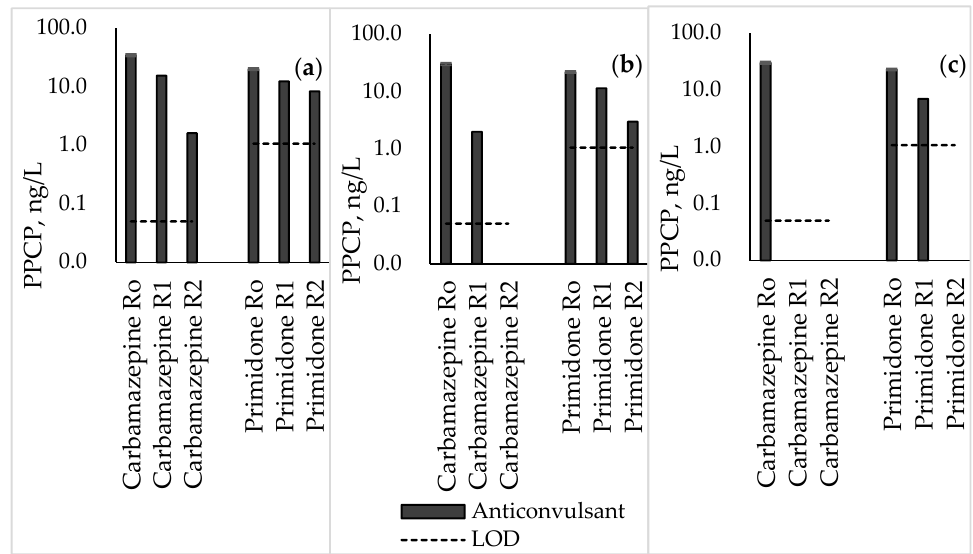
Figure 5. Concentrations of two anticonvulsants in the feed secondary effluent (R o ) and effluent of the R 1 and R 2 reactors at the O 3 doses of: ( a ) 1 and 2 mg L − 1 , respectively, in Run 1; ( b ) 2 and 4 mgL − 1 , respectively, in Run 2; and ( c ) 3 and 6 mg L − 1 , respectively, in Run 3.